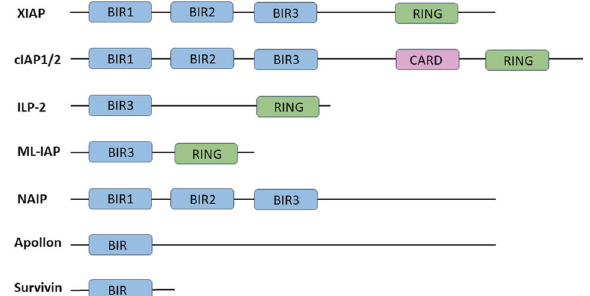
Fig. 4 The structure of IAP family members. IAP members all have at least one baculoviral IAP repeat (BIR) domain that facilitates